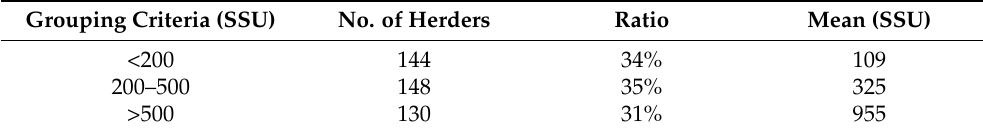
Table 1. Survey sample groups based on the number of livestock normalized by SSU *. Grouping Criteria (SSU) No. of